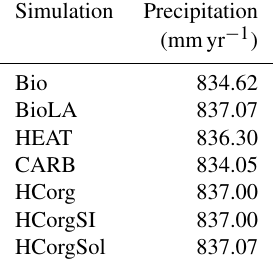
Table G1. Precipitation (mmyr − 1 ) for the different